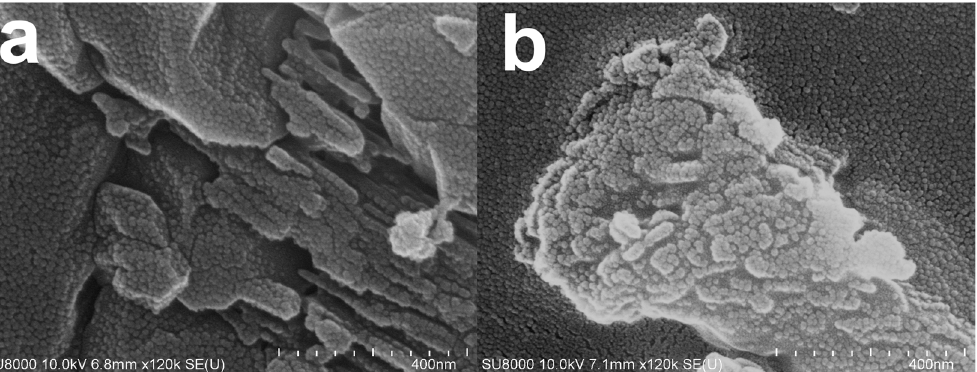
Figure 7. The SEM images of ( a ) green mussel waste shells calcined at 1000 °C for 3 h and ( b ) mixed shell powder calcined at 1000 °C for 2 h .